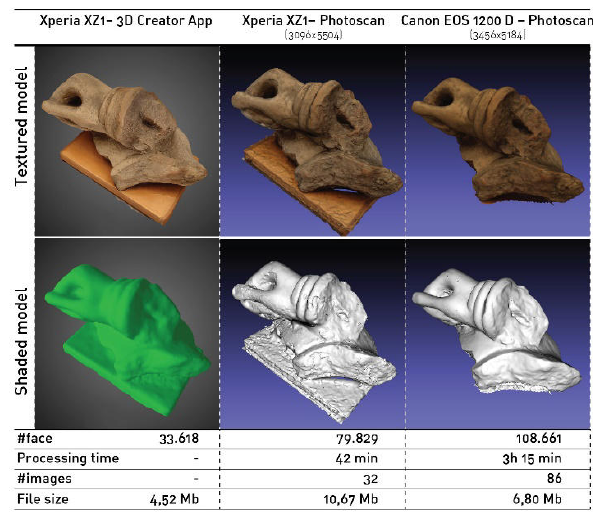
Figure 7. Comparative assessment-matrix on hand